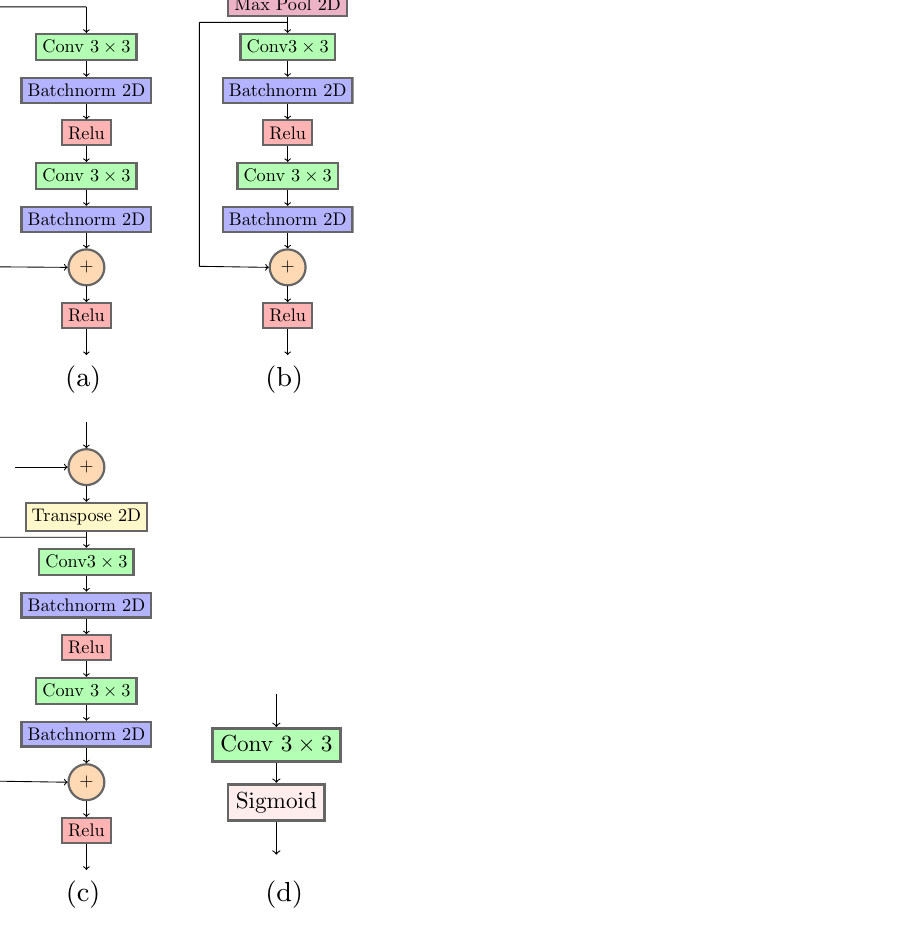
Figure 3. The blocks that make up the network structure. ( a ) The input block based on the residual unit. A 3 × 3 convolution is applied, followed by batch normalization, and a ReLU function. The same process is repeated again, but the original input features are added together before the last ReLU operation. ( b )The downward residual block is similar to the input block ( a ) except we apply a 2D max pooling operation to downsample the input features. ( c ) The upward residual block is similar to the input block ( a ) except a transpose is applied to upsample the input features. Features from the corresponding down layer are concatenated before being input to the transpose. ( d ) The output block is a simple 3 × 3 convolution followed by a sigmoid function to produce a final probability